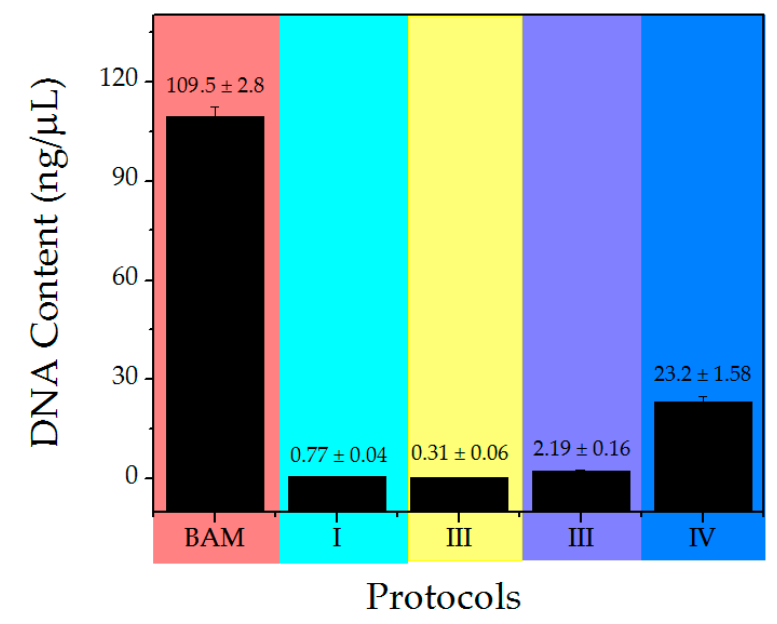
Figure 2. DNA content obtained for the control sample and decellularized membranes (DM).